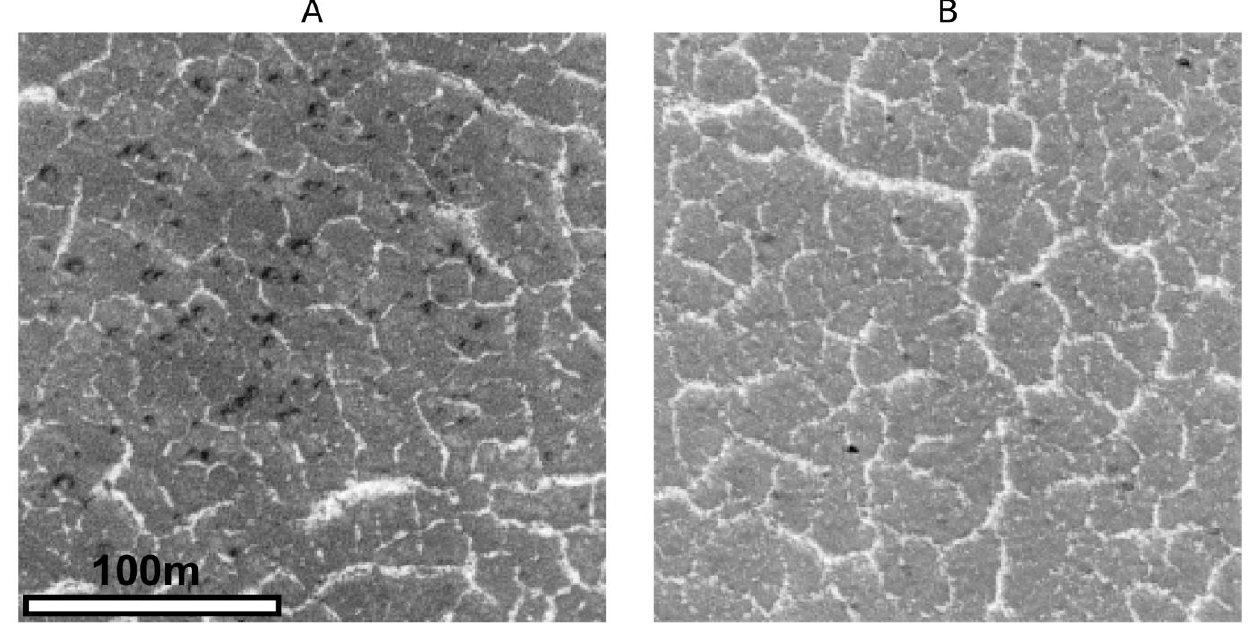
Figure 1. Synthetic imagery of polygonal terrain on Mars. ( A ) Real HiRISE imagery, ( B ) synthetic image generated by a trained StyleGAN network. Resolution for both images is 0.5 m/pixel.